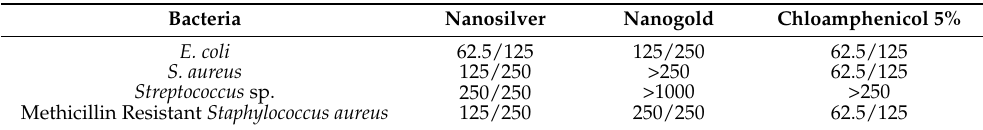
Table 2. Antimicrobial activity of silver and gold nanoparticle (MIC/MBC µ g/mL). MIC stands for minimum inhibitory concentration whereas MBC stands for minimum bactericidal